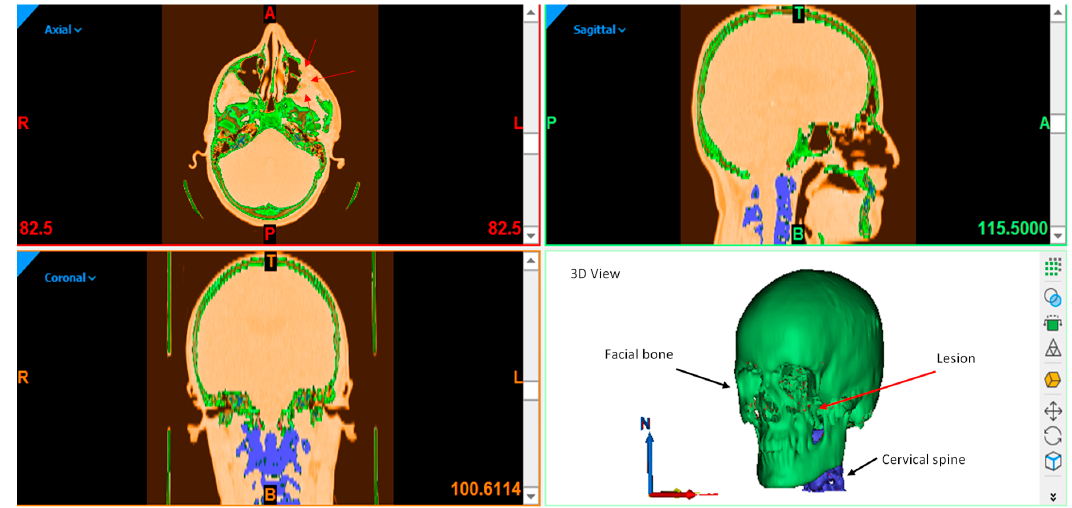
Figure 2. 3D model of the patient skull anatomy revealing the tumor location.